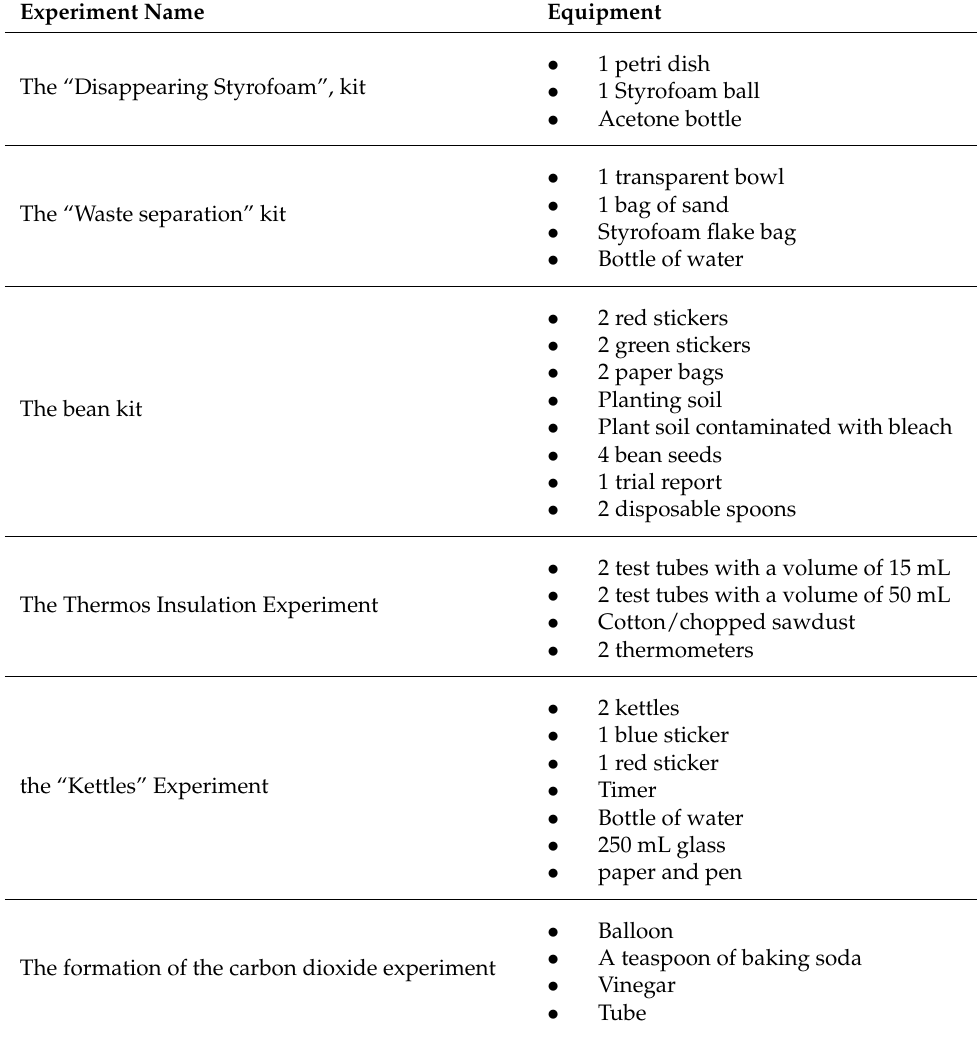
Table 1. Materials—Experiment